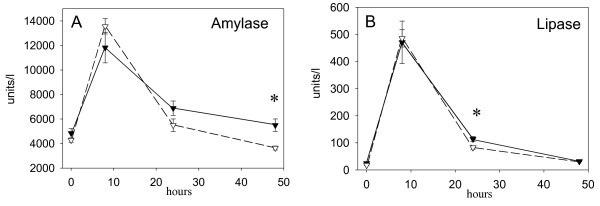
Serum levels of amylase and lipase during experimental pancreatitis in R122H-trypsinogen transgenic mice and controls: After induction of experimental pancreatitis serum levels of amylase (a) and lipase (b) were measured at time points 0, 8, 24, and 48 hours (see materials and methods) in a minimum of 4 animals per group (R122H transgenic mice: black triangels, wild-type mice: white triangels). Statistical analysis using the Mann-Whitney-Test with p < 0.05 was considered significant.